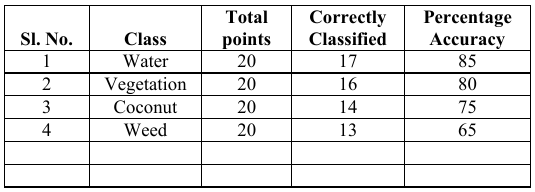
Table 4: Agricultural Feature Accuracy using KNN Classification